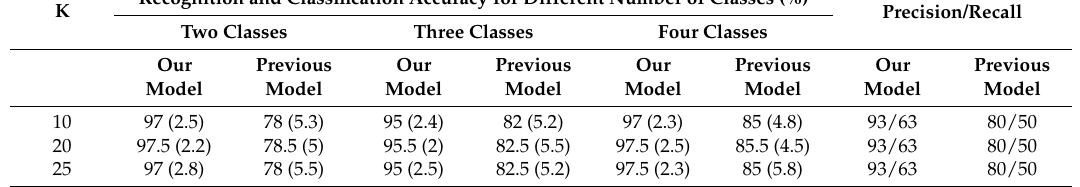
Table 4. A comparison of recognition and classification accuracy for different fabric textures and yarn colors between our model (deep ELM-based classifier) and the HMAX model with an SVM-based classifier (shirt fabric; inter-texture changes), with standard deviation in